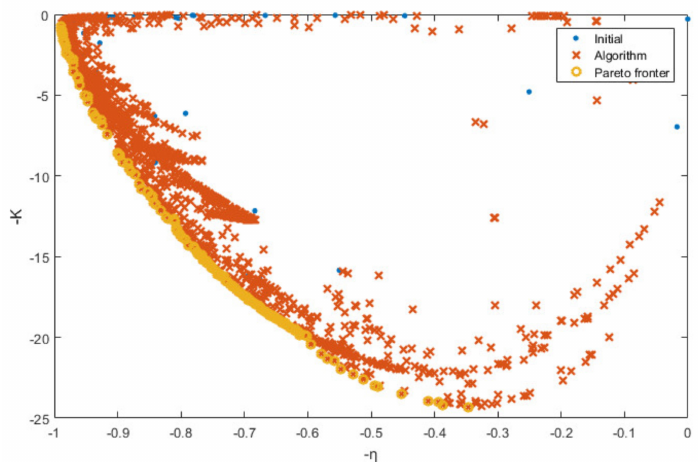
Figure 9. The visualization of final Pareto